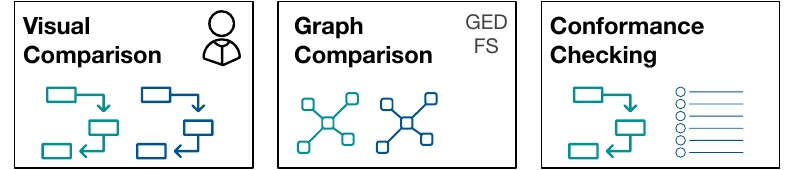
Figure 2. Overview of methods for pairwise comparison of process